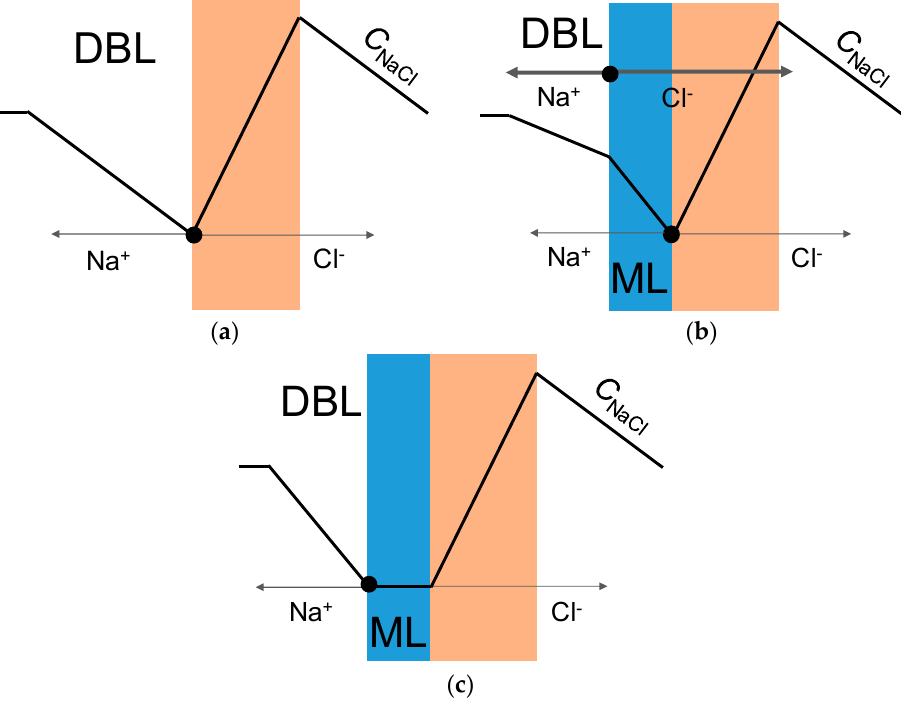
Figure 6. Limiting states reached at the commercial membrane ( a ), at the modifying layer/substrate membrane boundary of the modified membrane ( b ) and at the modifying layer/desalted solution boundary of the modified membrane ( c ). Pink zone denotes the substrate membrane, DBL denotes the (depleted) diffusion boundary layer and ML denotes the modifying layer. Black lines show the concentration profile of salt and grey lines show the fluxes of salt ions.